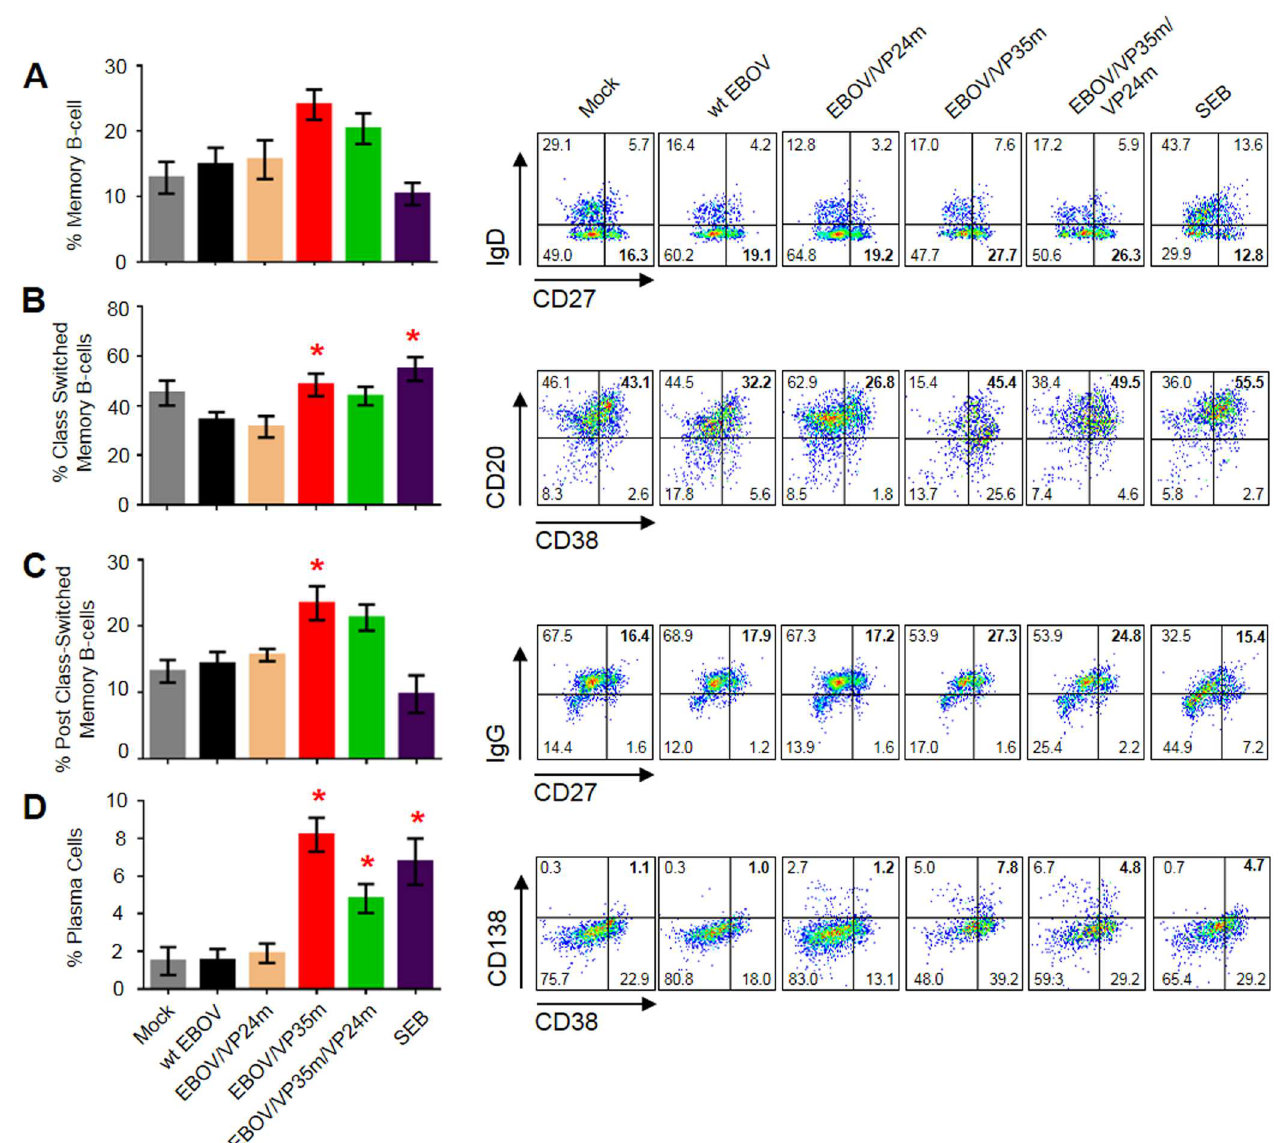
Fig 9. VP35 IID inhibits B-cell function and differentiation. Percentagesof CD19 + CD27 + IgD - memory B-cells ( A ), CD19 + CD27 - IgD - IgM - CD20 - CD38 ++ class switchedmemory B-cells ( B ), CD19 + CD27 +/Dim IgD - IgM - CD20 - CD38 - post class-switched memory B- cells ( C ), and CD19 + CD38 + CD138 + plasma cells ( D ) in PBMCs infected with wt EBOV or the mutant viruses. The subgatingstrategies are shown in S11B and S11C Fig. Average values based on 3 donors with SE shown. Statistically significantdifferences (P < 0.05)for the mutated viruses as comparedto wt EBOV are shown with red asterisks. Flow plots are representative primary data from one donor. Percentages of cell populations are indicatedin each quadrantwith that used for graphs at the left are